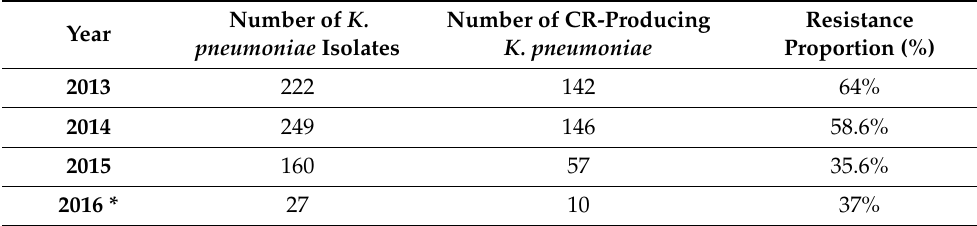
Table 3. Proportion of carbapenem-resistant Klebsiella pneumoniae per year.